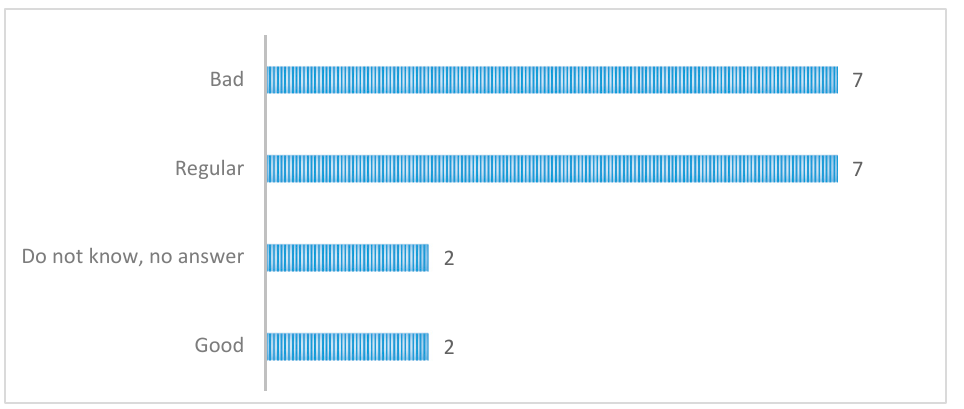
Figure 7. How do you value the operation of ATURIVE? Source: Own elaboration .